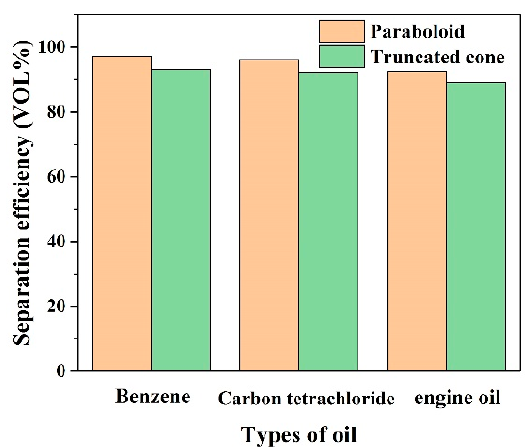
Figure 10. Results of separation efficiency for different oil-water mixtures.